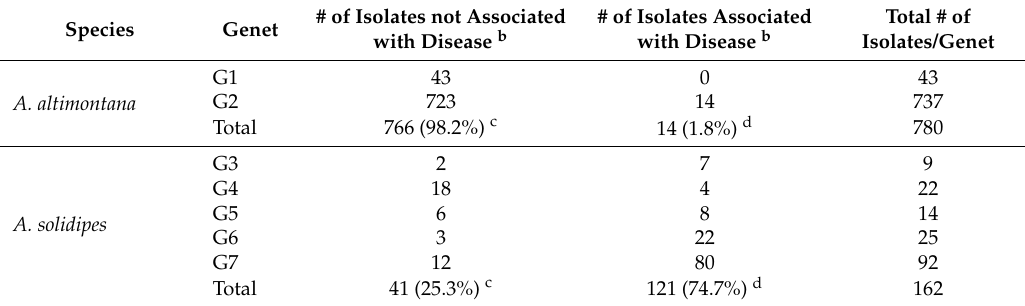
Total 41 (25.3%) c